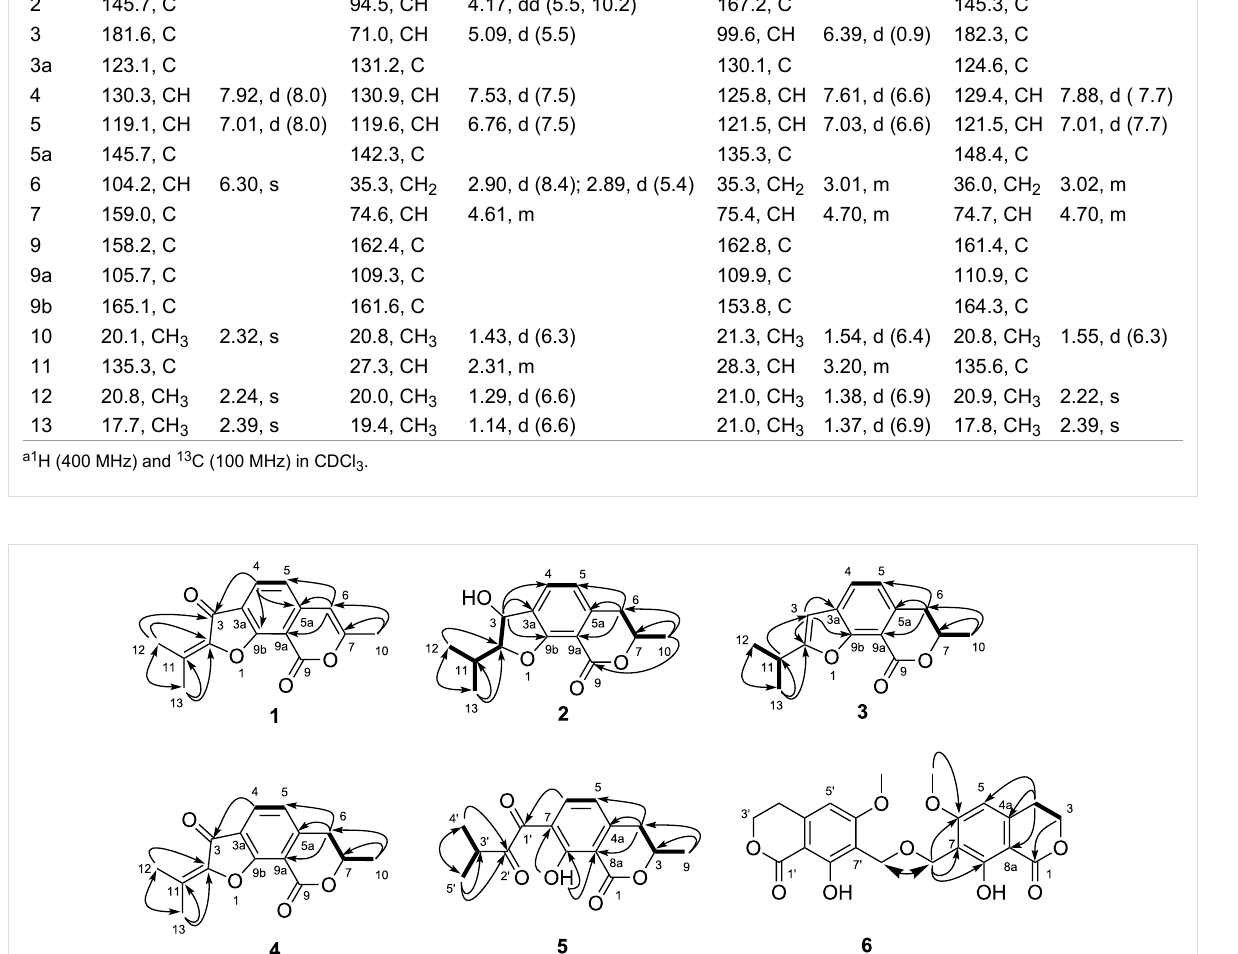
group at 3409 cm − 1 and the absence of a carbonyl group at 1737 cm − 1 in comparison with compound 1 . The 1 H NMR